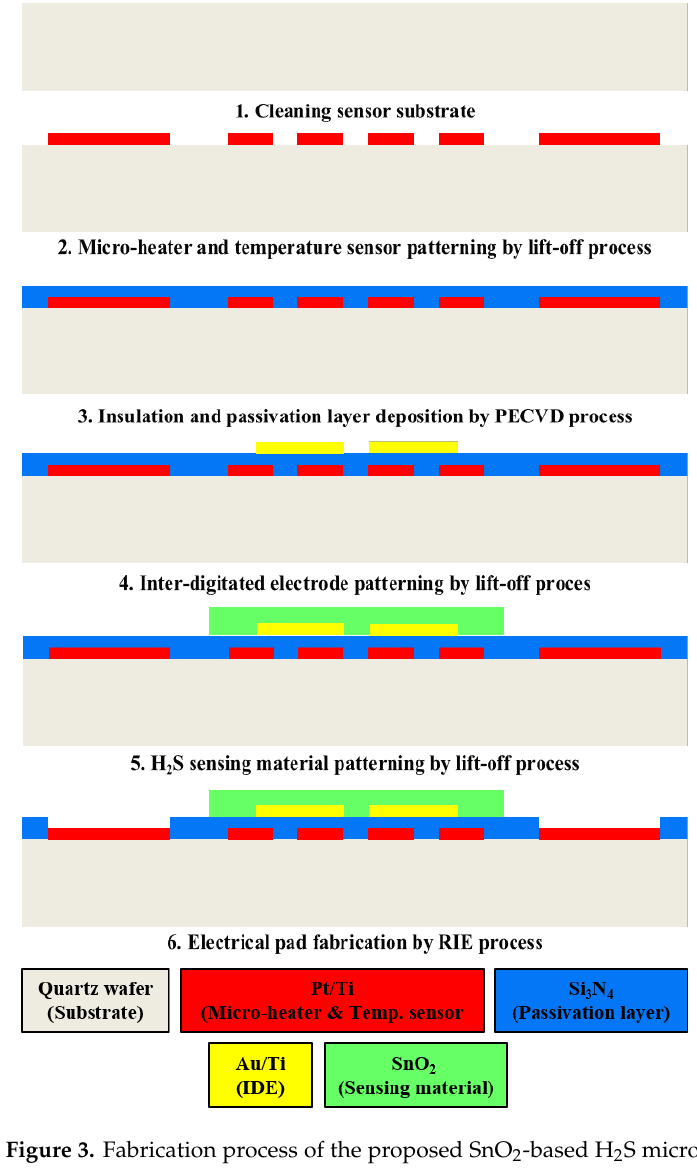
Figure 3. Fabrication process of the proposed SnO 2 -based H 2 S microsensor with micro-heaters of three